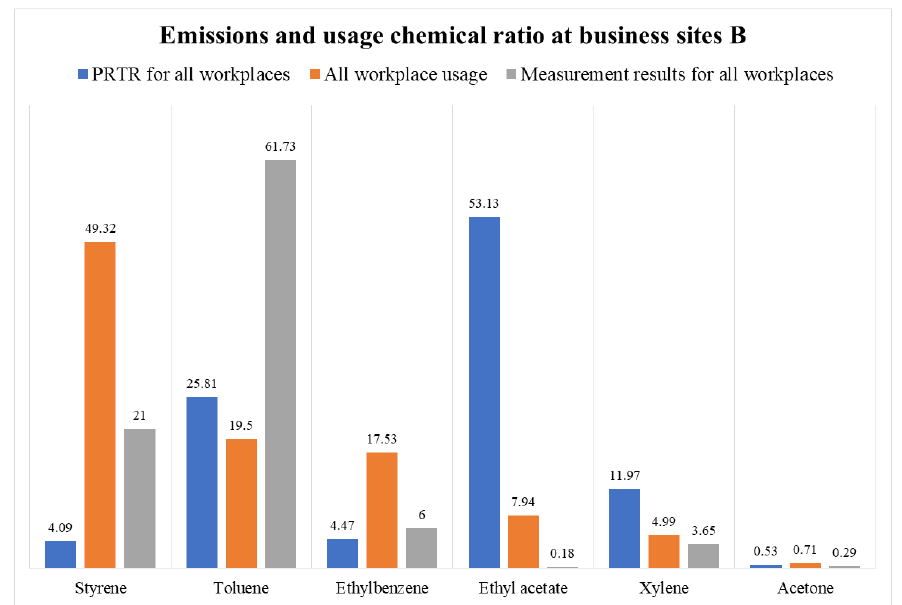
Figure 12. Emissions and usage chemical ratio at business sites B.